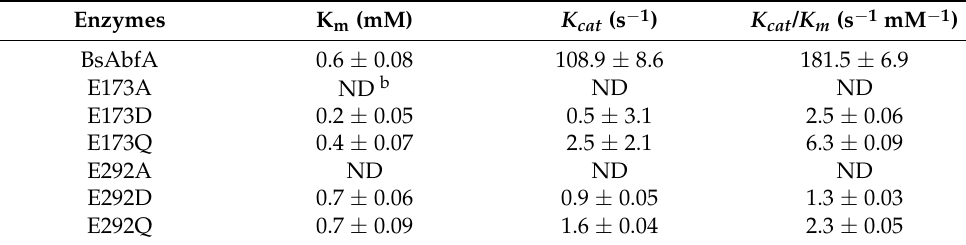
Table 2. Enzymatic parameters for hydrolysis of p NP- α -Af by optimized and mutated BsAbfA a .